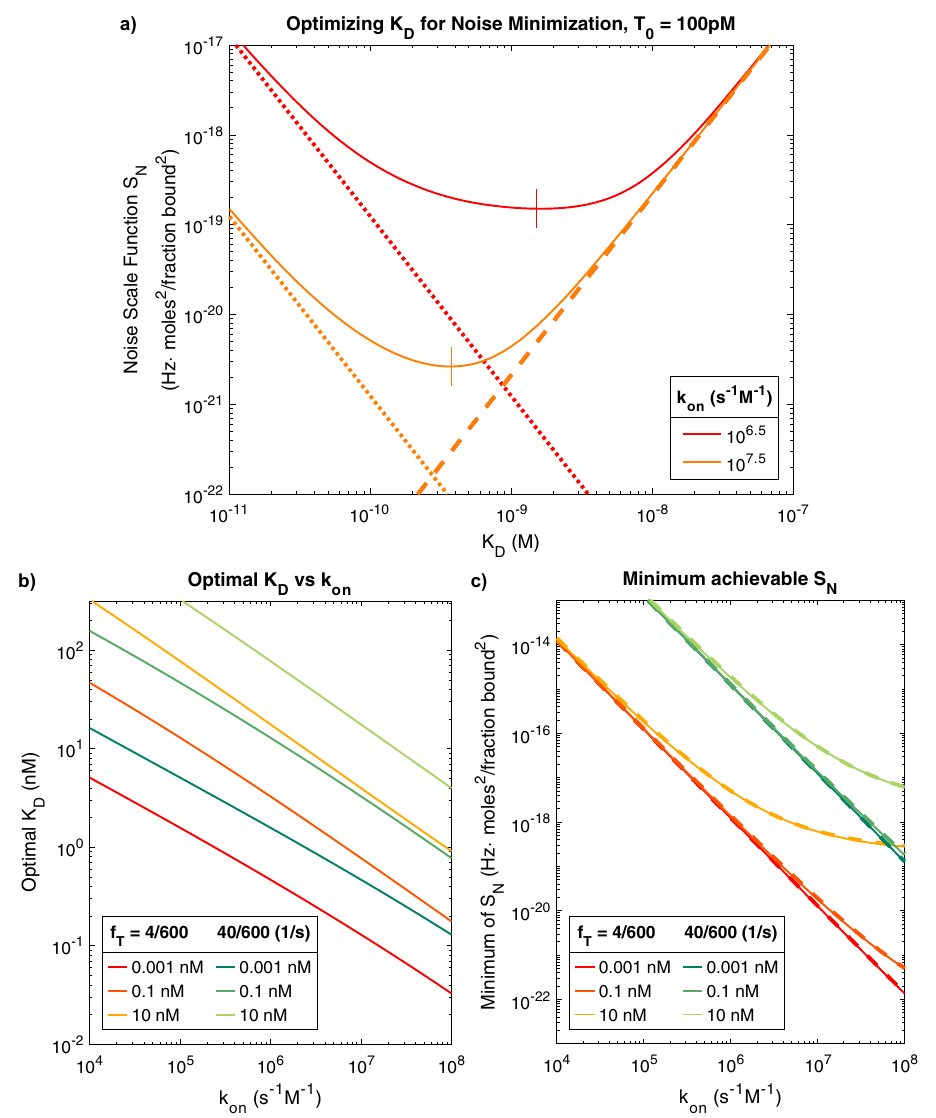
k off ! 1 (dashed lines) and for k off ! 0 (dotted lines). b The optimal K D corre- spondingtotheminimum S N wasobtainedforarangek on valuesfor T 0 =0.001,0.1, and 10nM for insulin sensors with f T = 4/600Hz (four harmonics, target period 600s) and f T =40/600Hz (40 harmonics, target period 600s). c The minimum achievable S N (corresponding to optimal K D values) for the same conditions as